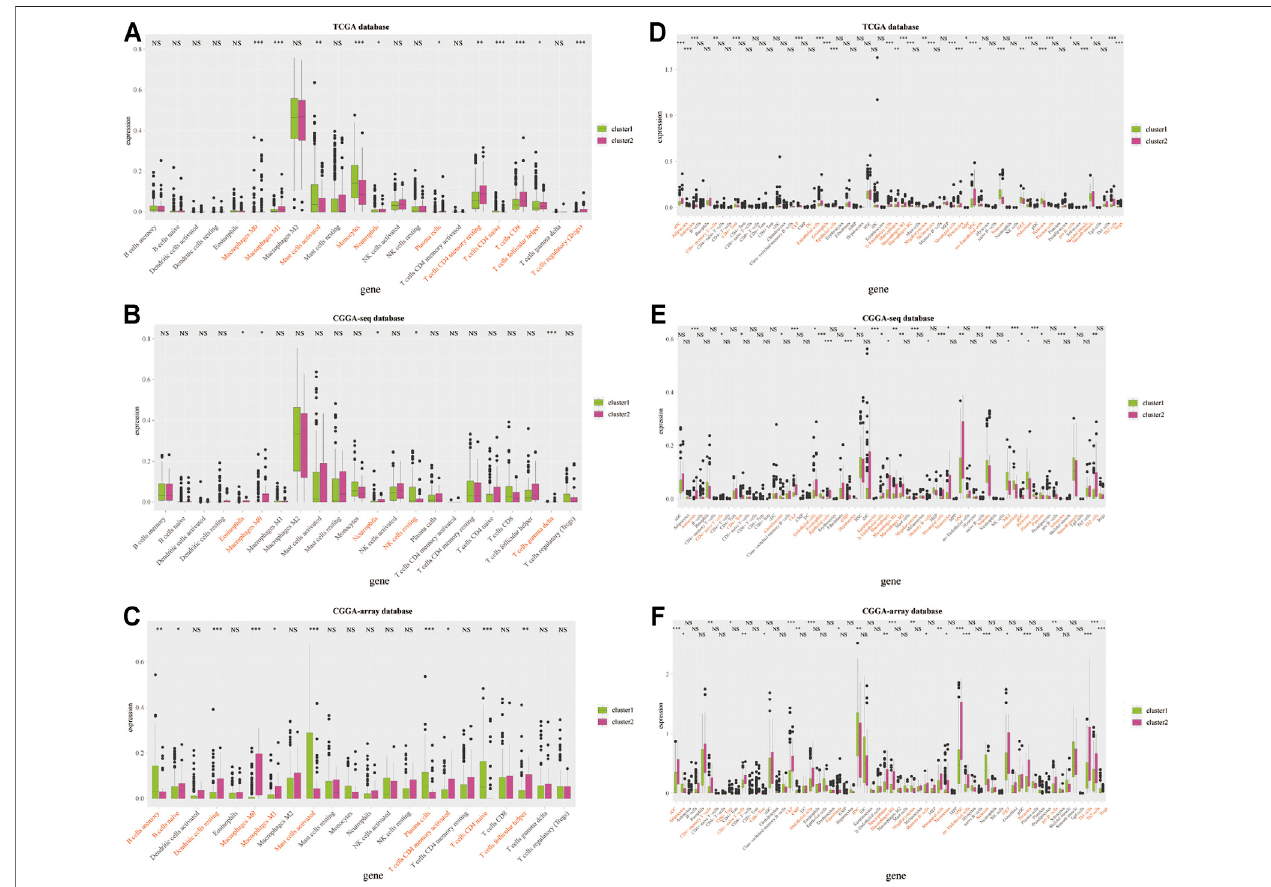
FIGURE 4 | In fi ltrated immune cells in cluster 1 and cluster 2 from the training and validation cohorts. Immune in fi ltrates in two clusters based on the CIBERSORT algorithmfromtheTCGA (A) ,CGGA-sequence (B) ,andCGGA-array (C) databases.Immunein fi ltratesintwoclustersbasedonthexCELLalgorithmfromtheTCGA (D) , CGGA-sequence (E) , and CGGA-array (F) databases. * p < 0.05, ** p < 0.01, *** p < 0.001, NS, no signi fi cant differences.